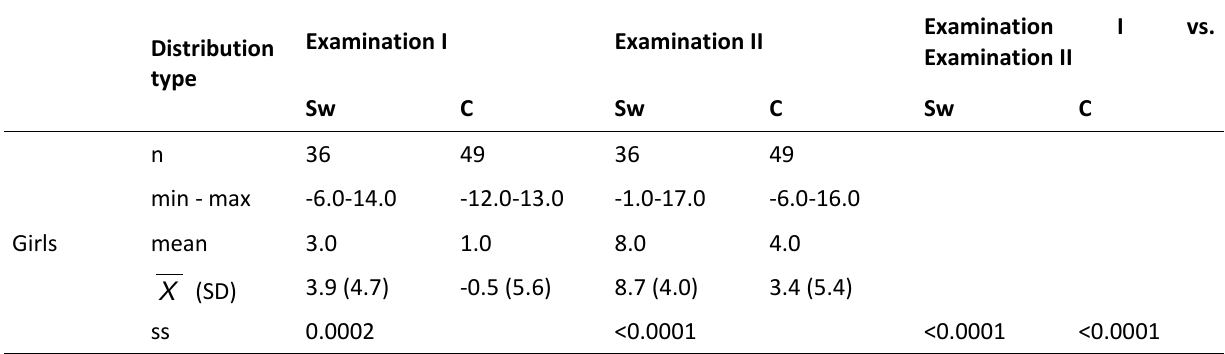
Fig 2. Changes of Plate Tapping Test (speed of upper limb movements) results in the Swimmers group (Sw) and Control group (C) Table 4. Descriptive characteristics of Sit-and-Reach Test (flexibility) results in Swimmers (Sw) group and Control (C) group